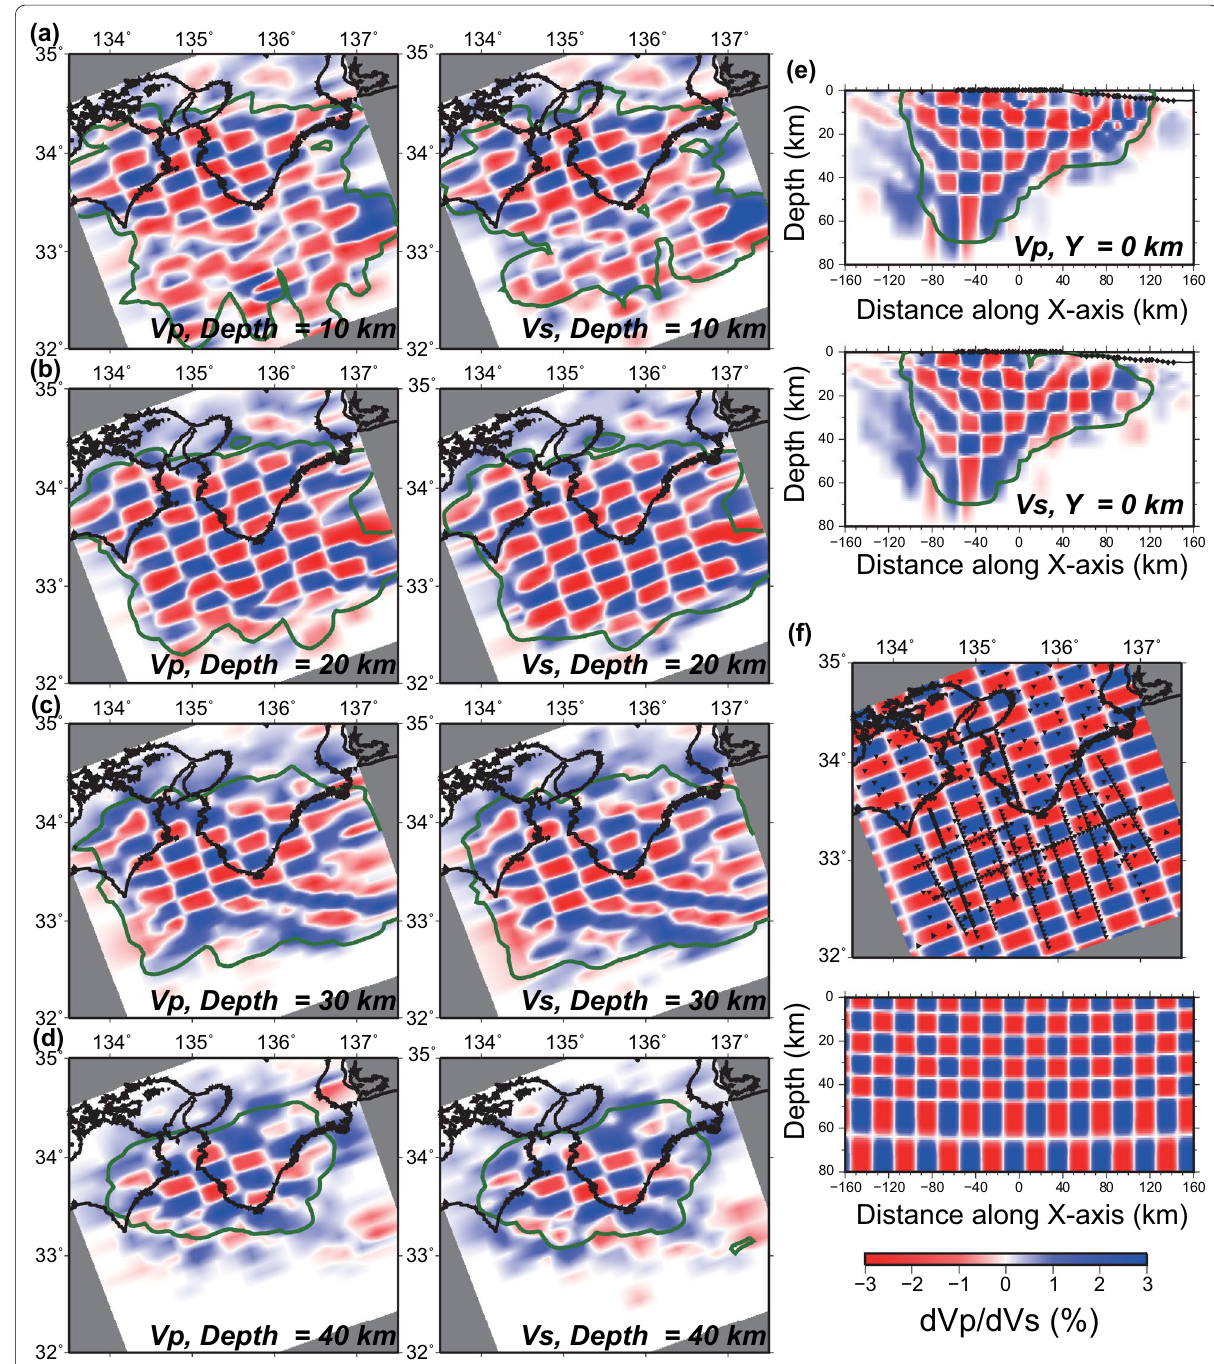
Fig. 4 Checkerboard resolution test results. a At 10 km, b 20 km, c 30 km, and d 40 km depth and e along the vertical profile at Y lines outline areas where the derivative weight sum (Thurber and Eberhart-Phillips 1999) is > 1000 for the P-wave model and > 500 for the S-wave model. f Assumed checkerboard